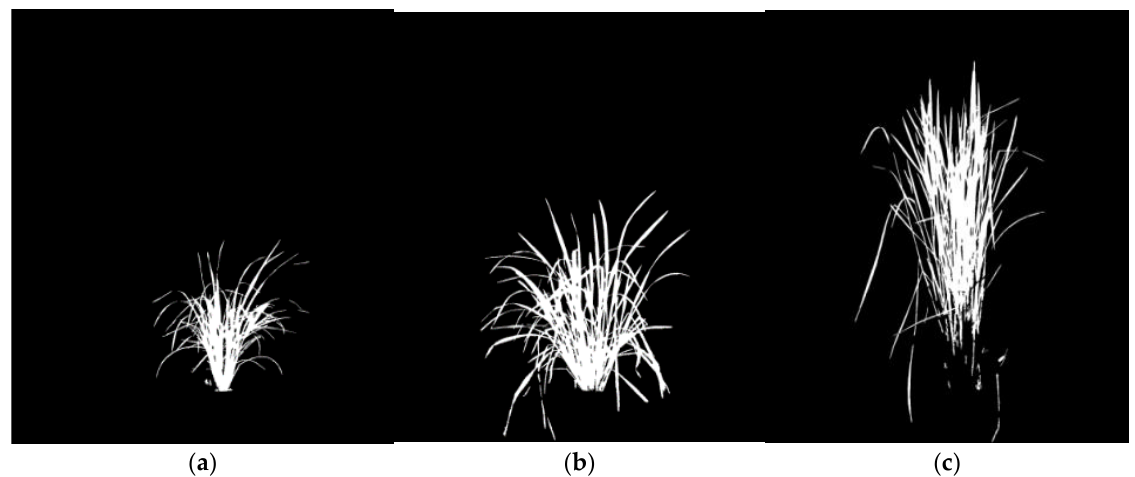
Figure 2. Sample binary graphs of rice growth in three stages. ( a ) shows the tillering stage of rice; ( b ) shows the jointing stage of rice; ( c ) shows the heading and grain-filling stage of rice.